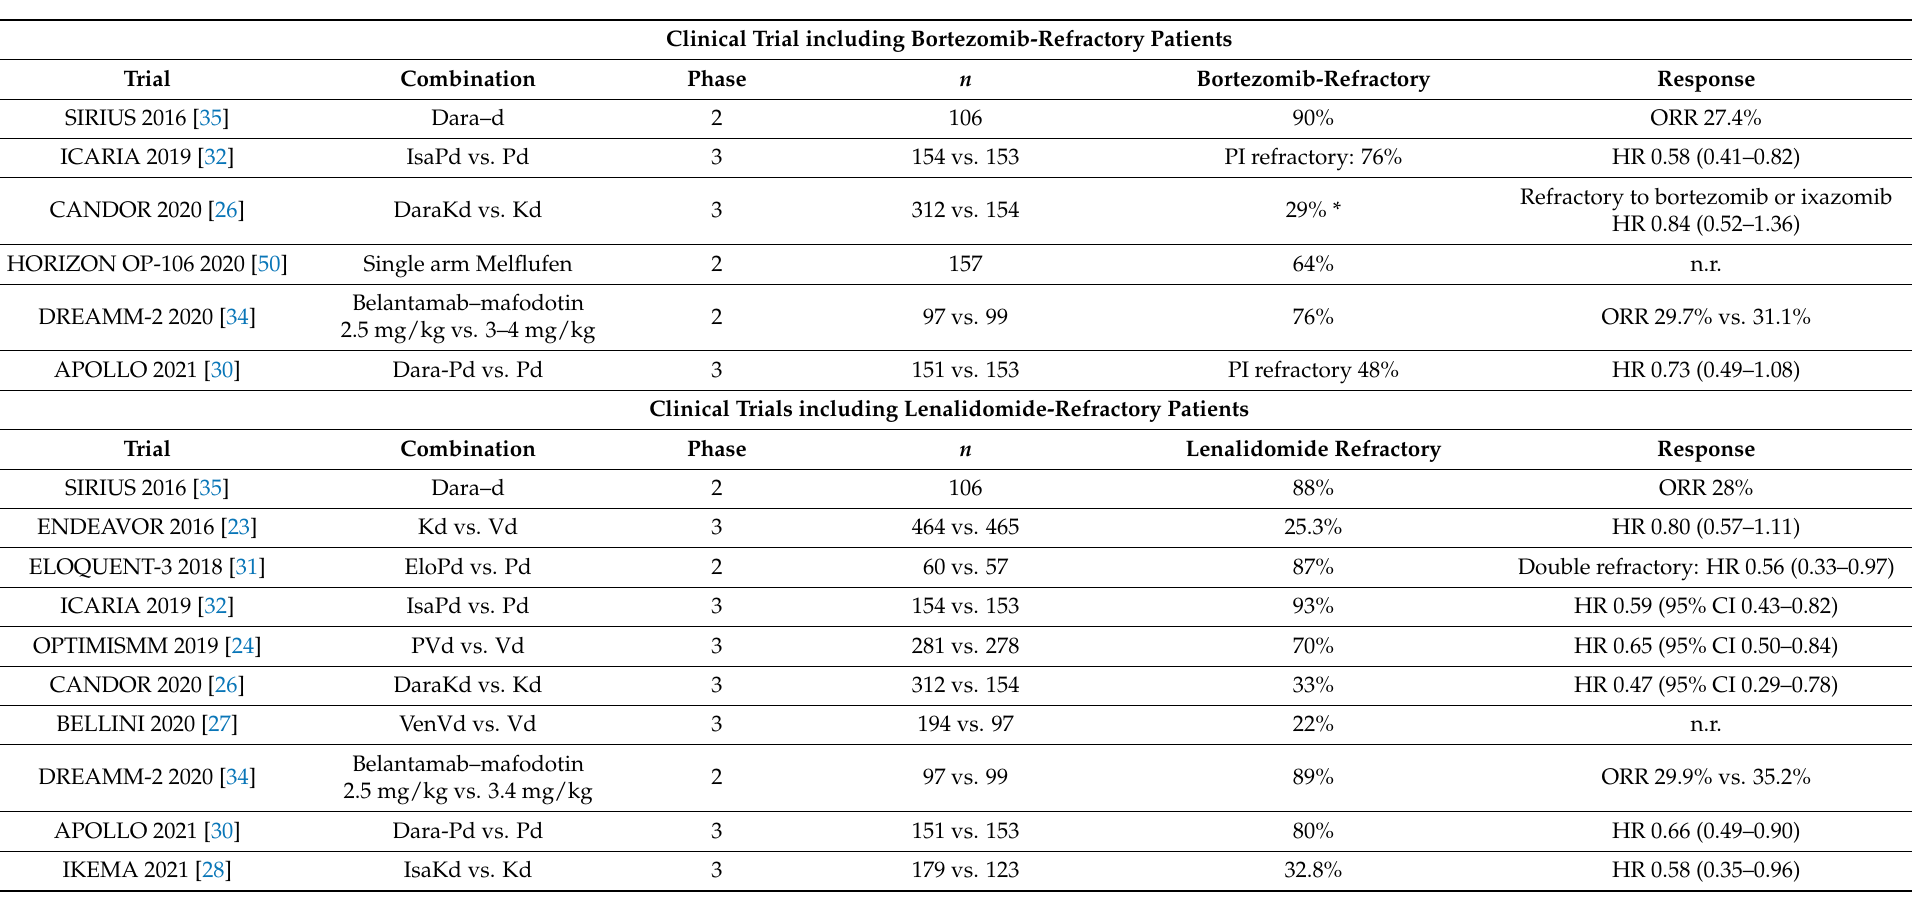
Table 2. Recent trials including patients refractory to prior therapy